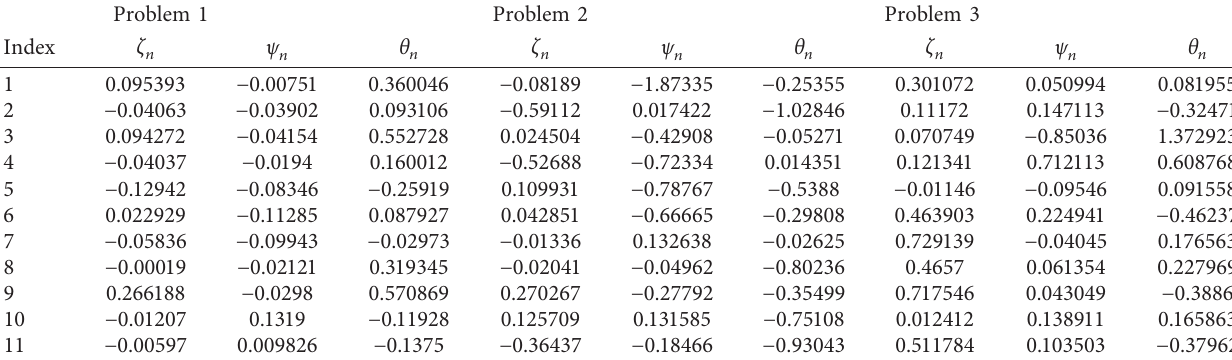
Table 7: Trained neurons obtained by LeNN-NM algorithm for Problems